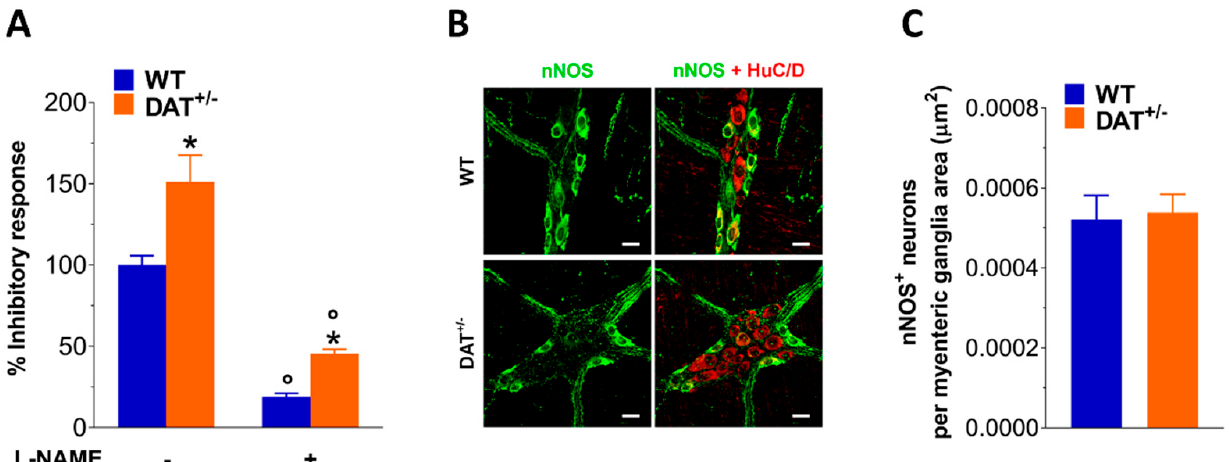
Figure 3. DAT influences NO-mediated relaxation. ( A ) 10 Hz EFS-evoked relaxation in NANC conditions with or without or 100 µ M L-NAME (pan-NOS inhibitor) in ileal segments of WT and DAT +/ − mice. ( B ) Representative confocal microphotographs showing the distribution of HuC/D (red) and nNOS (green) and ( C ) analysis of nNOS + neurons in ileal LMMPs of WT and DAT +/ − mice (bars = 22 µ m). Data are reported as mean ± SEM. * p < 0.05 vs. WT; ◦ p < 0.05 vs. respective control in NANC condition. n = 5 mice/group.